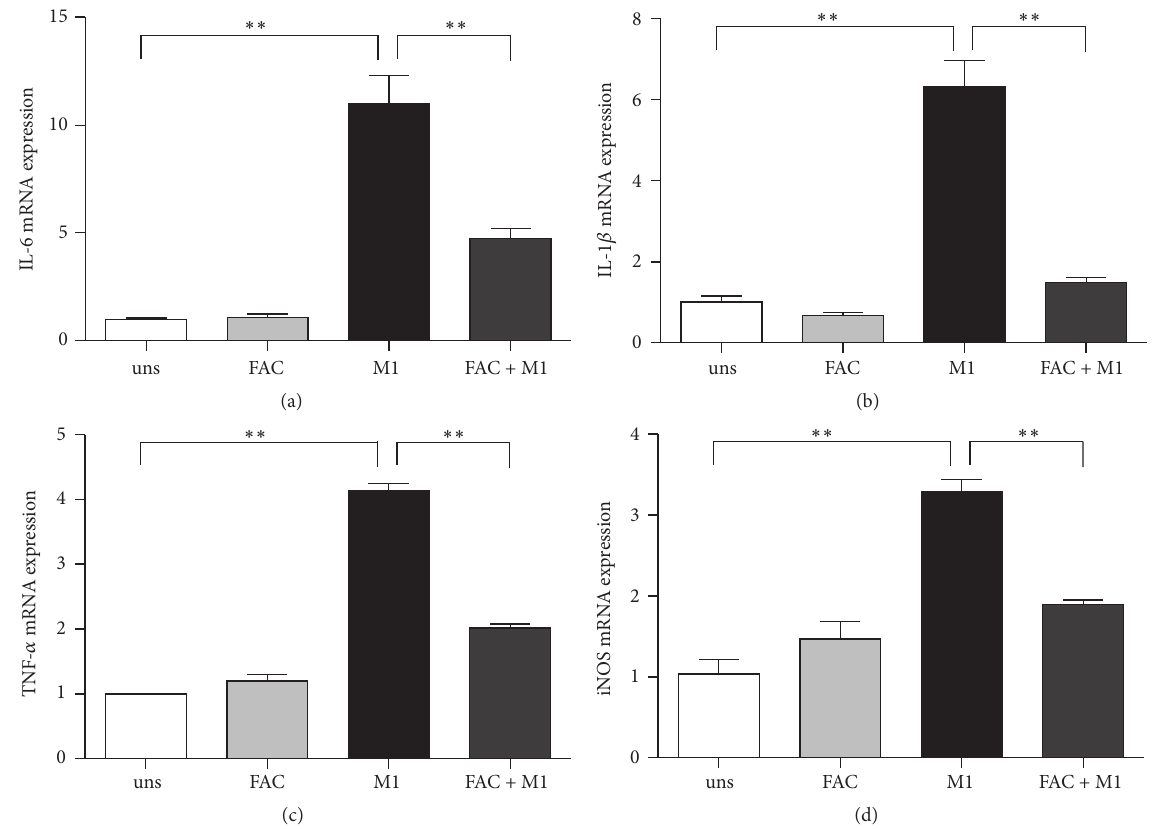
Figure 3: Effects of iron on mRNA expression in M1 macrophage. (a) IL-6, (b) IL-1 𝛽 , (c) TNF- 𝛼 , and (d) iNOS mRNA expression were assessed by real-time PCR. Gene expression is represented as fold-change compared to unstimulated macrophages. Data are mean ± SD for three independent experiments. (uns: unstimulated macrophages; ∗∗ 𝑝 < 0.01